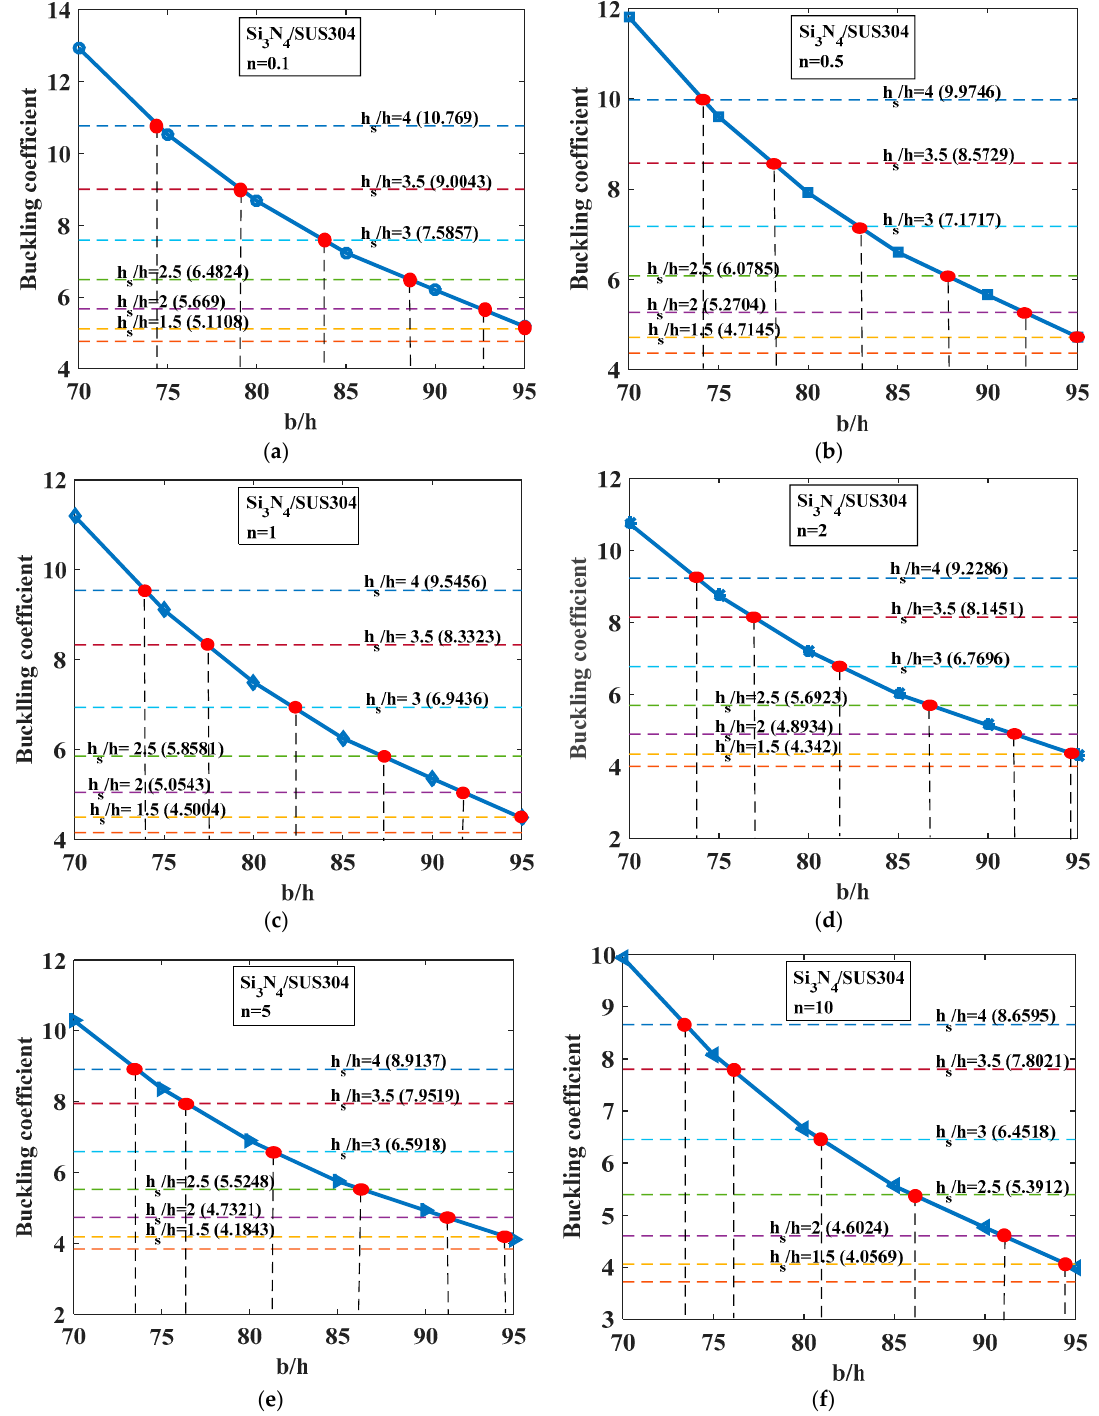
Figure 4. Buckling coefficient of FGM (Si 3 N 4 /SUS304) plate. Solid blue line: buckling coefficient of plate without stiffeners ( b / h = 70–95); horizonal dash-dot line: buckling coefficient of plate with a central stiffener ( b / h = 100) with various h s / h ratios. ( a ) n = 0.1; ( b ) n = 0.5; ( c ) n = 1; ( d ) n = 2; ( e ) n = 5; ( f ) n =10. Table 4. Buckling coefficient of FGM plate with and without a central stiffener (Si 3 N 4 /SUS304, b / h = 100).